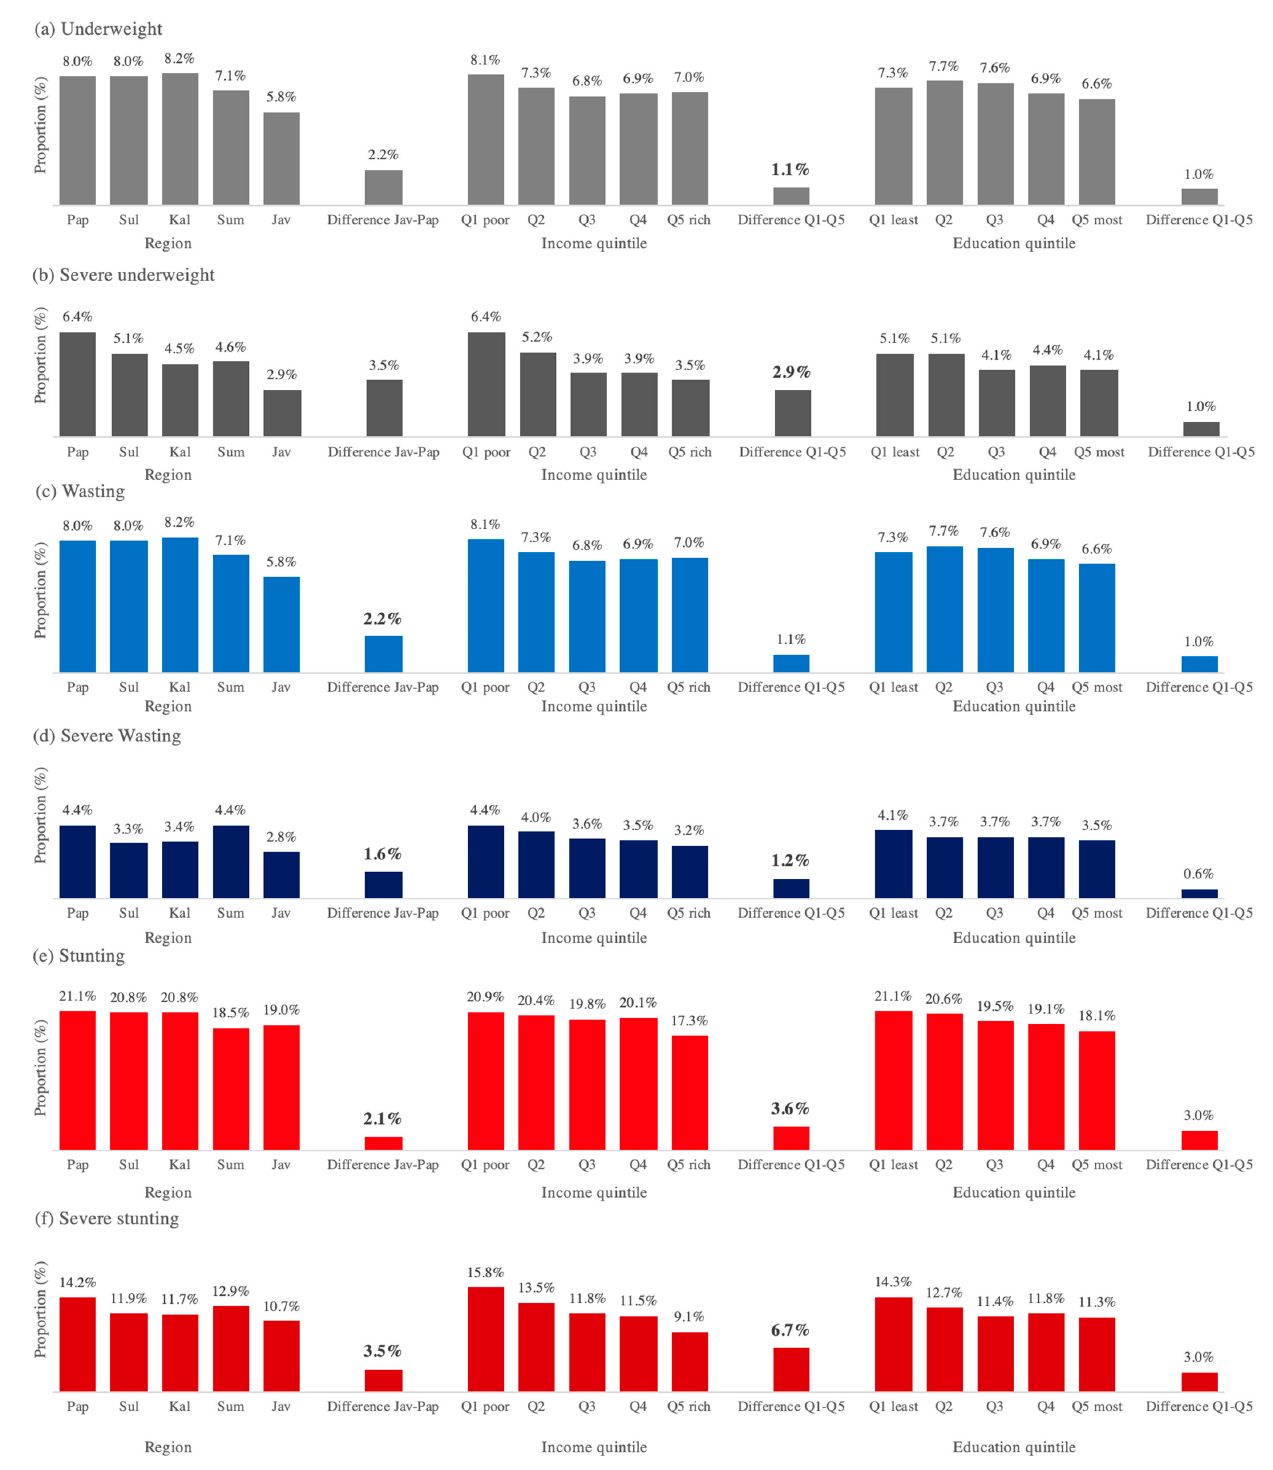
Figure 4. Note: Q = Quintile; Jav = Java region including Bali; Pap = Papua region including Maluku and Nusa Tenggara; Sul=Sulawesi region; Kal = Kalimantan region; Sum = Sumatera region. Income quintile used district-level poverty rate (Q1 = 20% of districts with highest poverty rate). Difference = Absolute difference between Papua and Java as well as Q1 and Q5. Appendix B shows the relative difference (ratio) between Papua and Java as well as Q1 and Q5. Appendix B also provides results stratified by urban/rural. Boldface difference values show statistical significance at a 5% level (see Appendix C for the regression